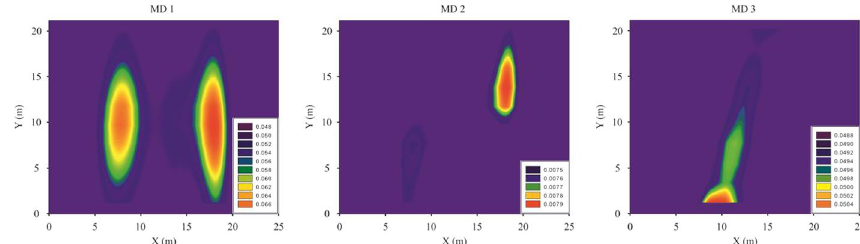
Fig. 14 Two-dimensional view of the detected damage extent for 3 single damage scenarios in the noise-free